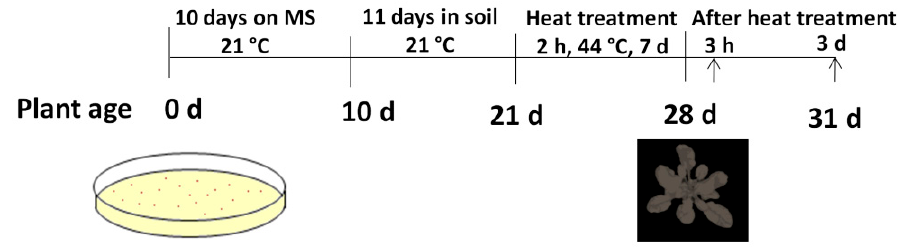
Figure 1. Schematic representation of experimental design; arrows denote the time of sampling.